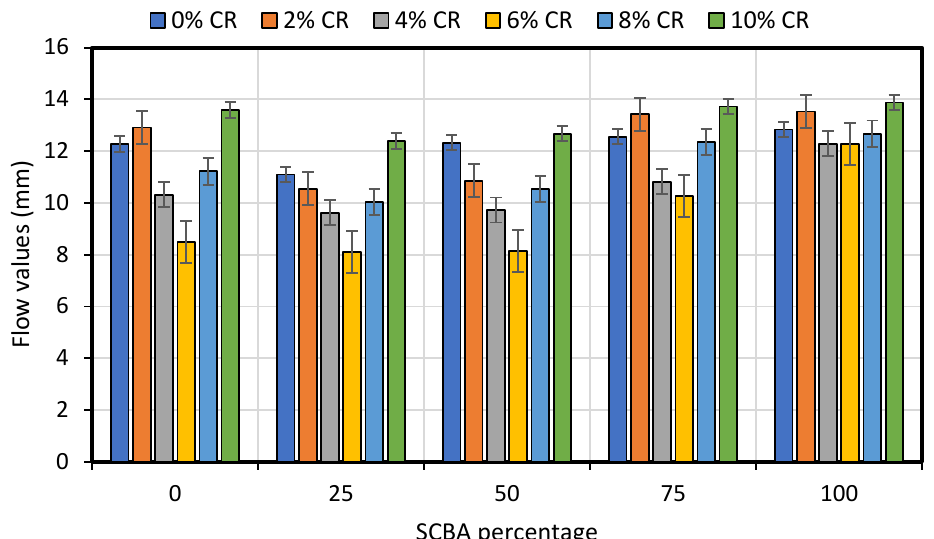
Figure 10. Effect of additions of CR and SCBA on flow of asphalt concrete.